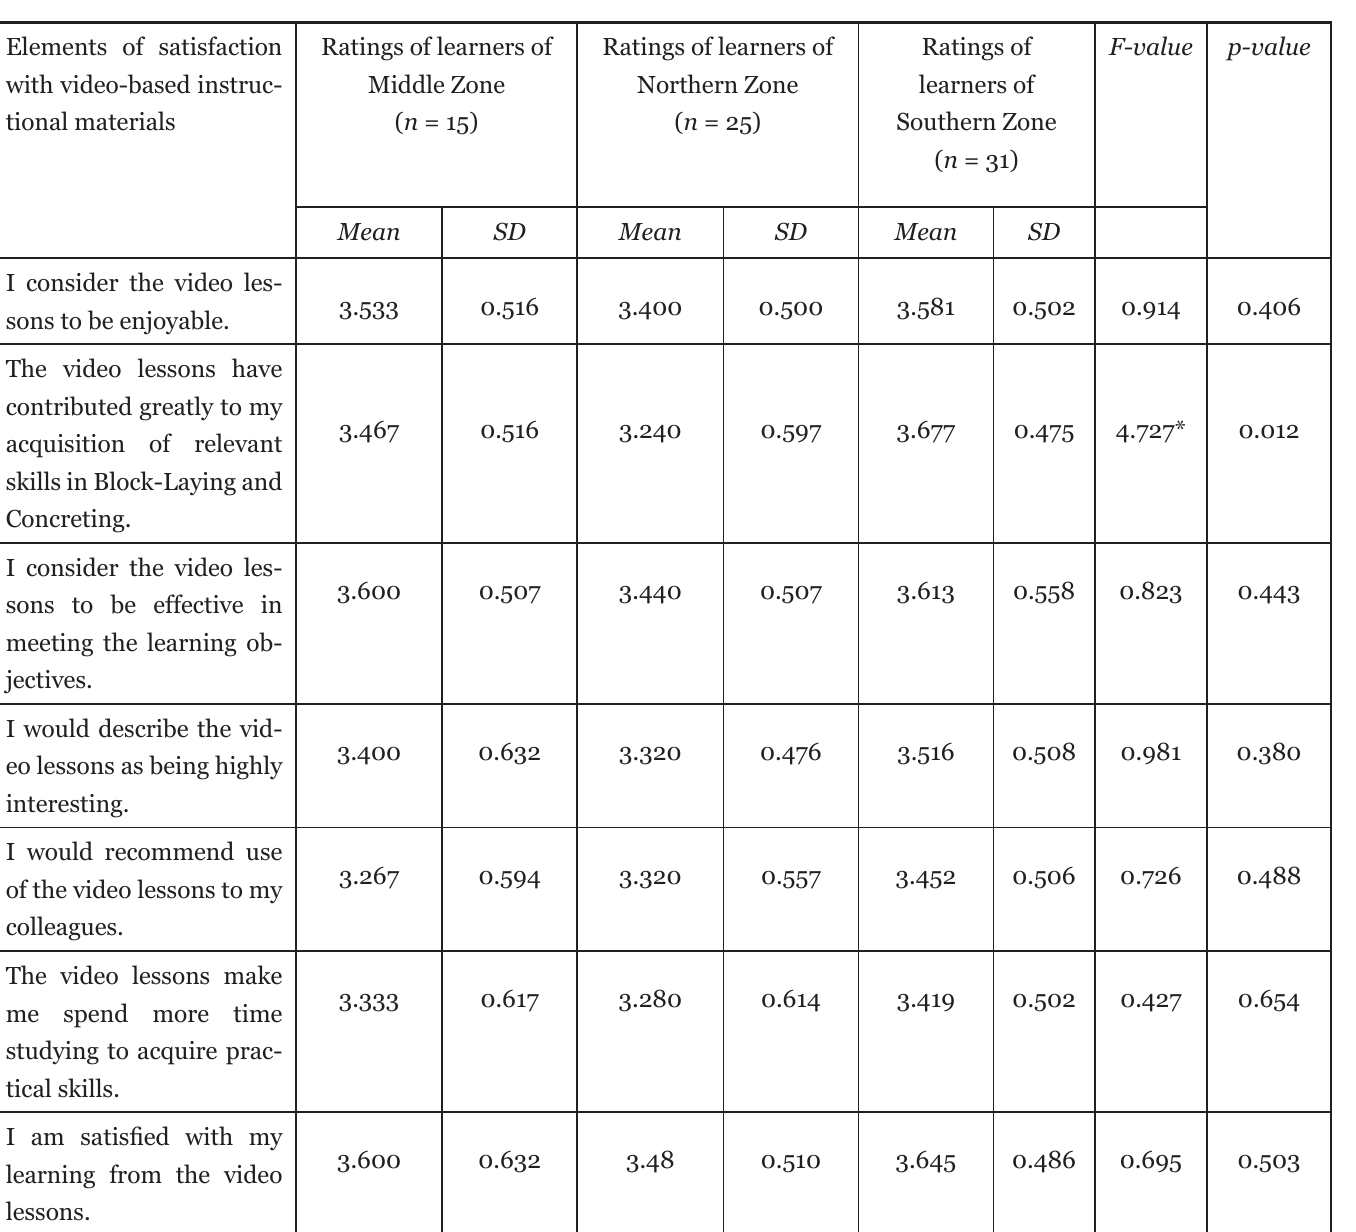
Results of ANOVA for Ratings of Items of the Learner Satisfaction Scale Categorized ac- cording to Study